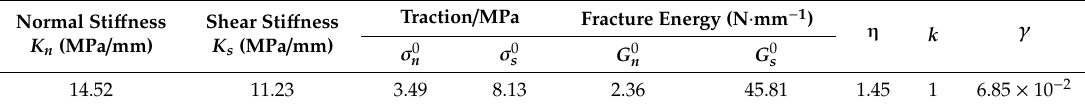
Figure 5. Constitution of interface for mixed-mode delamination. Table 2. Material parameters of the steel / concrete interface.